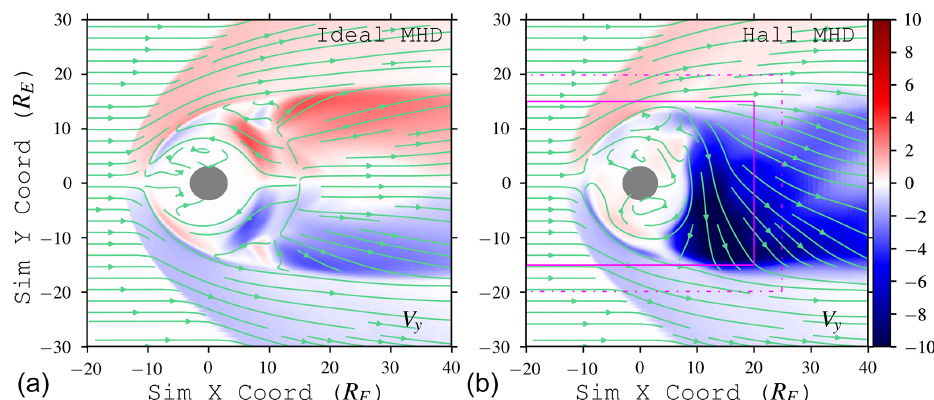
Figure 1. Cross-tail velocity V y in the tail plane perpendicular to reconnection for both ideal (a) and Hall (b) MHD, normalized to v 0 = 97 . 9kms − 1 . Streamlines show in-plane velocity. Purple lines in the right figure surround the highest resolution regions: (cid:49)x,(cid:49)y = 0 . 2 R E (solid); (cid:49)x,(cid:49)y ≤ 0 . 515 R E (dot-dashed). A typical Dungey-like, symmetric convection pattern induced by numerical resistivity is clearly demonstrated in ideal MHD. Adding the Hall term induces out-of-reconnection-plane flows, which drives an asymmetric convection pattern; this is similar to what has been simulated for Ganymede (Dorelli et al., 2015; Tóth et al., 2016; Wang et al., 2018).